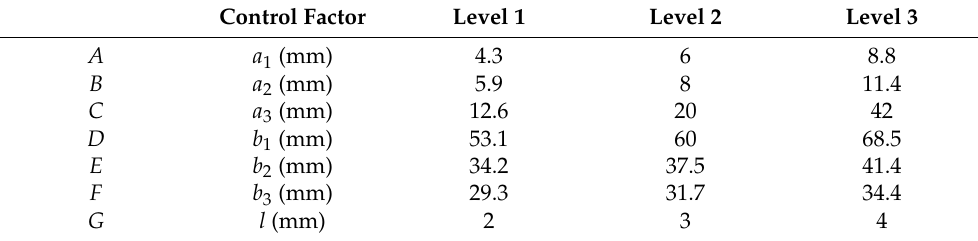
Figure 2. Control factors of the LRSCs structures in a single row of resonators. Table 1. Summary of control factors and their relative levels.